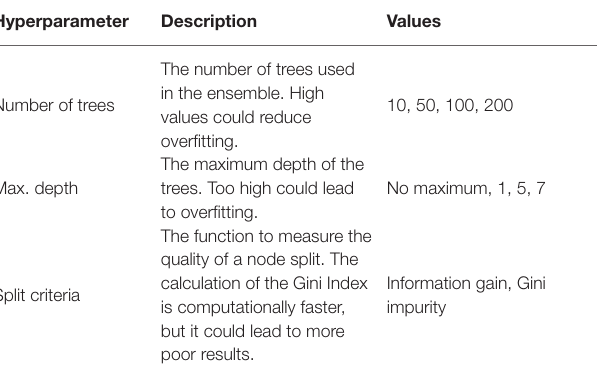
TABLE 2 | Hyperparameters evaluated for optimizing the ensemble learning